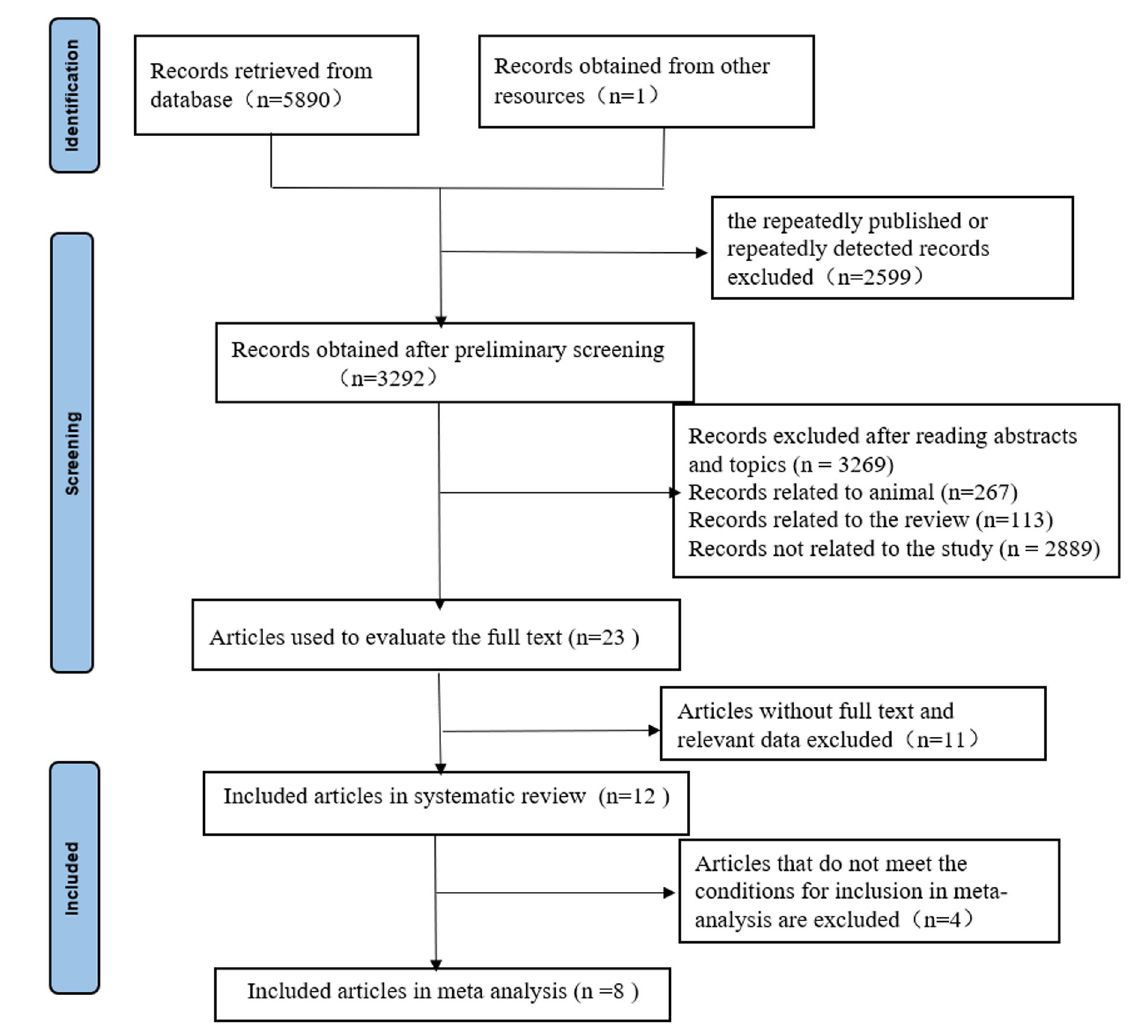
Fig 1. PRISMA flow diagram depicting study selection